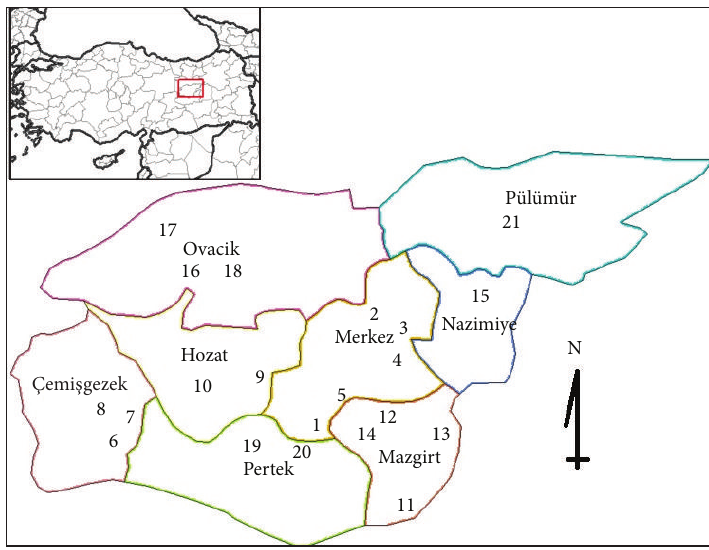
Figure 1: Locations of sampling